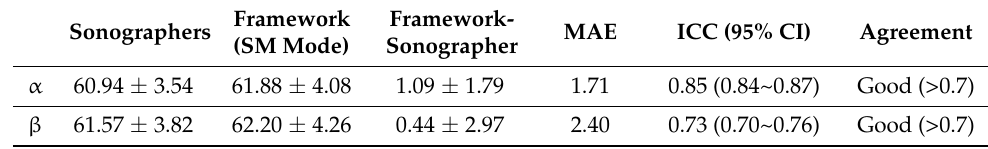
Table 2. Comparison of angle measurement between SM mode and sonographers.